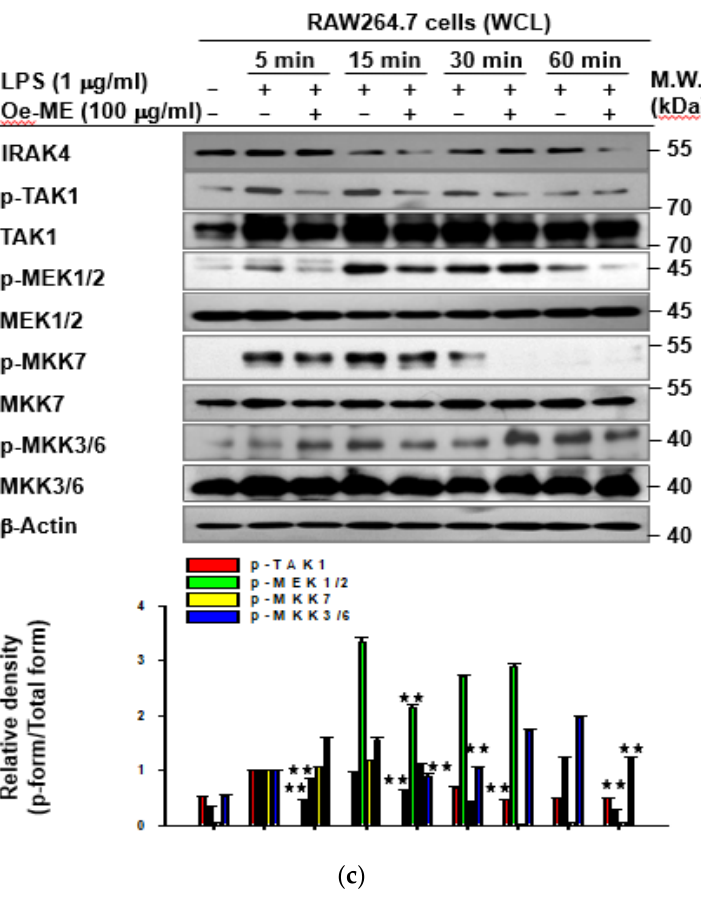
Figure 3. The effect of Oe-ME on mitogen activated protein kinase (MAPK) activation and its upstream signaling. ( a ) RAW264.7 cells were treated with Oe-ME or vehicle and were then induced by LPS for 5, 15, 30, and 60 min. The phosphorylated and total forms of MAPKs and MAPKKs in the whole cell lysates were detected. ( b ) MAPK inhibitors were used to verify the role of MAPKs on LPS stimulation through RT-PCR. ( c ) RAW264.7 cells were treated with Oe-ME or LPS for indicated periods of time. Phospho- and total forms of MEK1/2, MKK7, and MKK3/6 were determined by immunoblotting analysis. Band intensity was measured and quantified using ImageJ. ## p < 0.01 compared with the normal group, and * p < 0.05 and ** p < 0.01 compared with LPS alone treated with the corresponding concentration of the vehicle (DMSO).